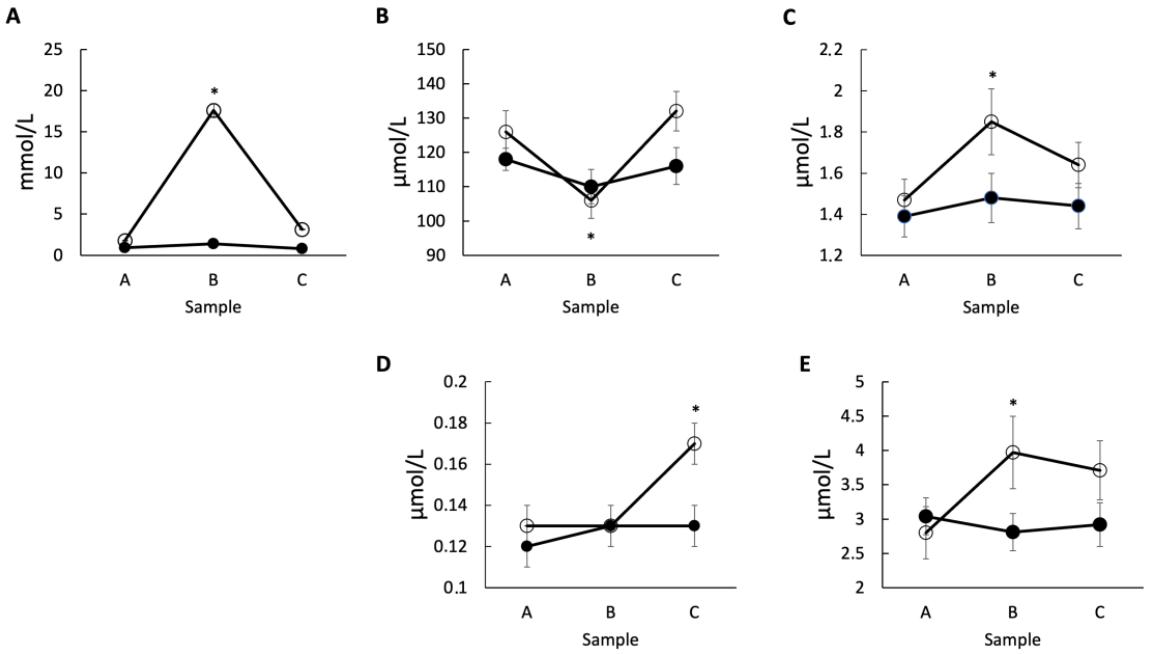
Figure 2. The metabolites with significant changes related to physical activity. The concentrations of ( A ) LA, ( B ) Trp, ( C ) Kyn, ( D ) XA, and ( E ) NAm were measured in the samples collected pre-exercise (Sample A), 10 min post-exercise (Sample B), and 60 min post-exercise (Sample C) in the group subjected to the low-intensity (solid circle) or high-intensity (open circle) exercise. Each measurement was performed in triplicates and * indicates p < 0.05 relative to sample A.